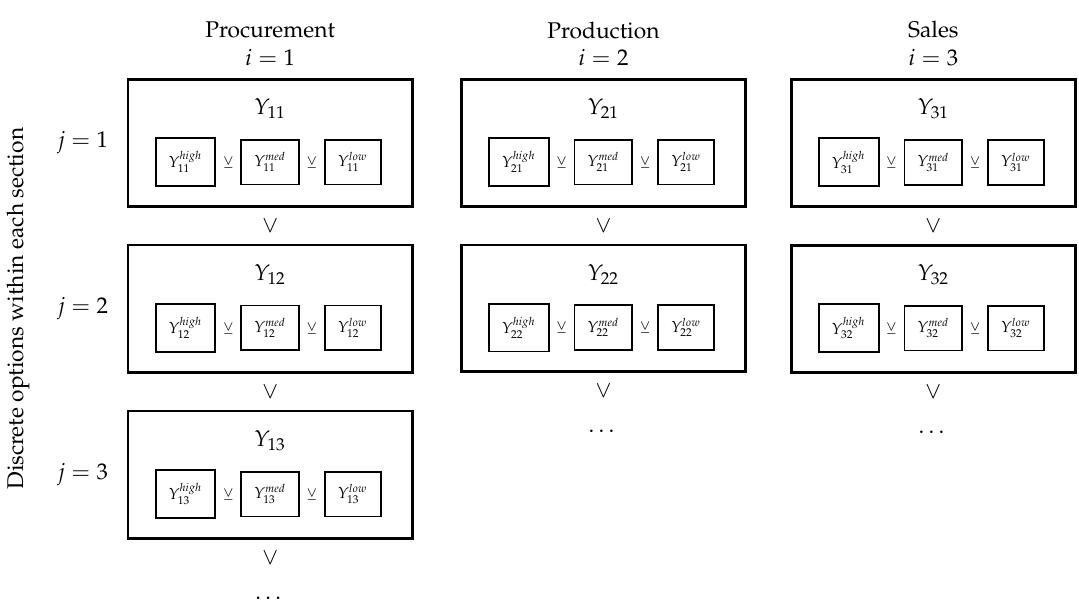
Figure 1. Example process illustrating the embedding of multiple detail levels within discrete options for each process